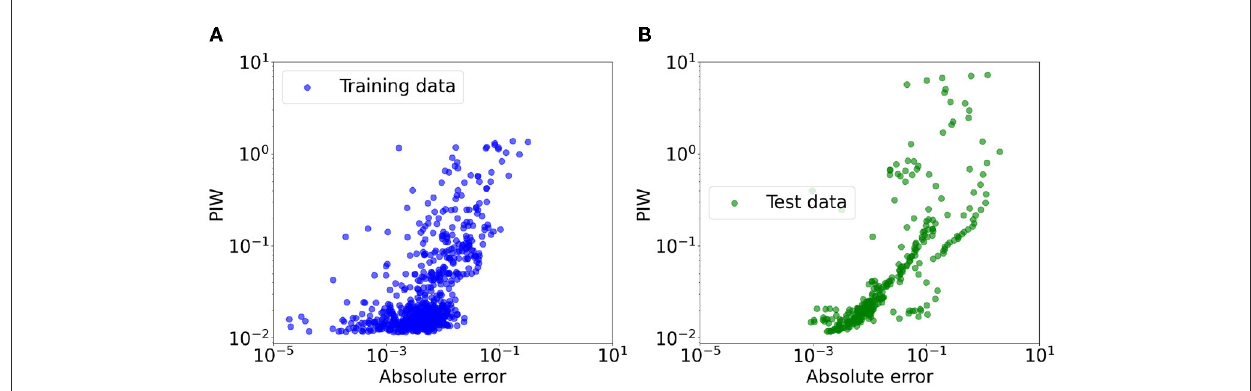
FIGURE8 Scatter plots of absolute prediction errors VS. the PIW for both the training (A) and test (B) data sets in Rock creek catchment. The prediction interval shows error-consistent uncertainty where high uncertainties (i.e., large PIWs) correspond to large